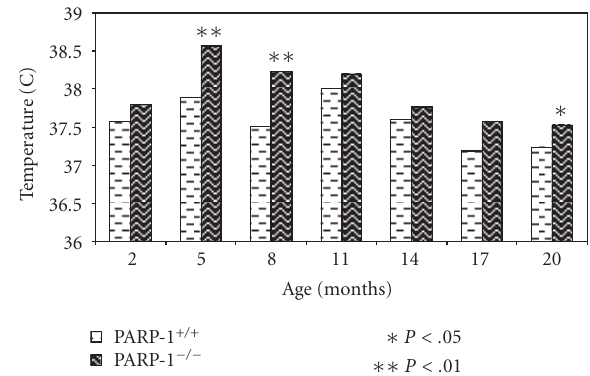
Figure 2: Age-related dynamics of body temperature in PARP- 1 − / − and PARP-1 + / + mice. Bars represent the body temperature of PARP-1 − / − and PARP-1 + / + mice at indicated age. Student’s t test was performed to analyze the statistical significance of the